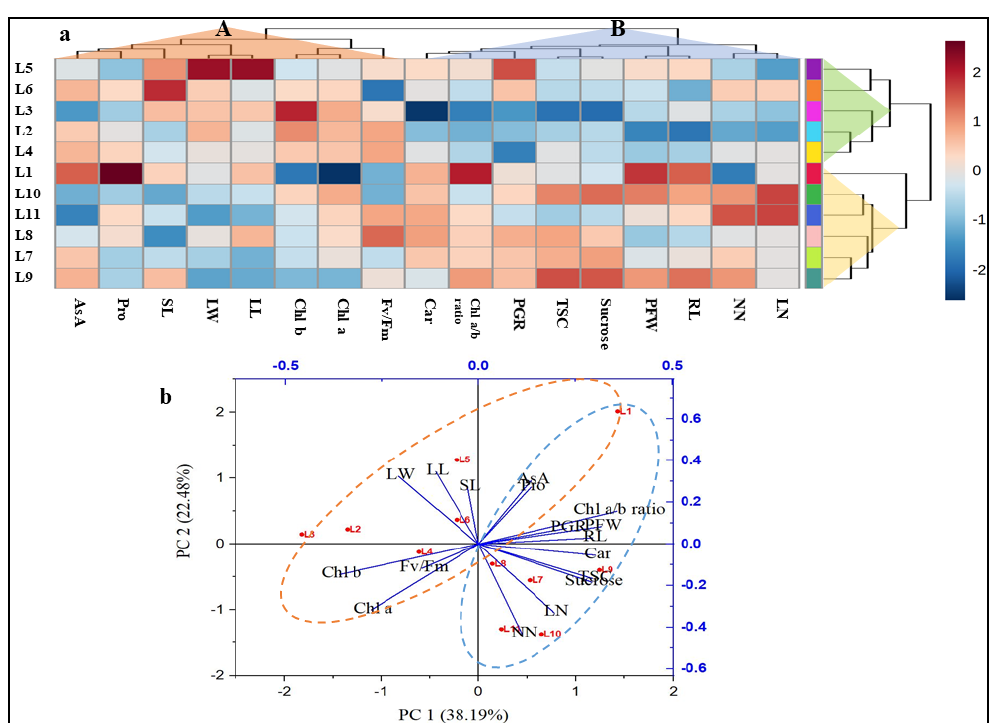
Figure 7. Hierarchical clustering and heatmap analysis ( a ) and principal component analysis (PCA) ( b ) to elucidate the variable treatment relationships among the eleven treatments for 20 days. In the heatmap, the mean values of the various parameters obtained in this study were normalized and clustered. At the variable level, two major clusters were recognized for each treatment. The color scale displays the intensity of the normalized mean values of the different parameters. In the PCA, the lines starting from the central point of the biplots display the negative or positive associations of the different variables, and their proximity specifies the degree of correlation with specific treatment. L1, Natural light; L2, White; L3, R 8 :B 2 ; L4, R 7 :B 2 :G 1 ; L5, R 7 :B 2 :FR 1 ; L6, R 6 :B 2 :G 1 :FR 1 ; L7,